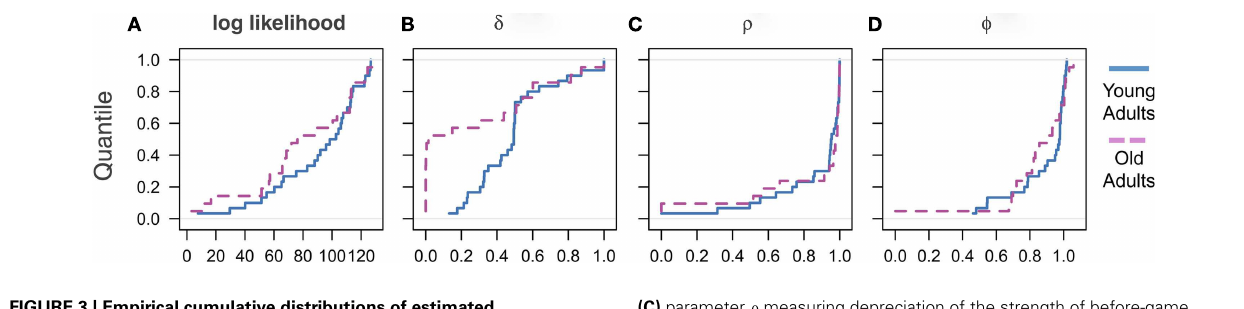
FIGURE 3 | Empirical cumulative distributions of estimated parameters across cohorts. (A) Log likelihood values measuring degree of model fit, (B) parameter δ capturing the degree of belief learning,